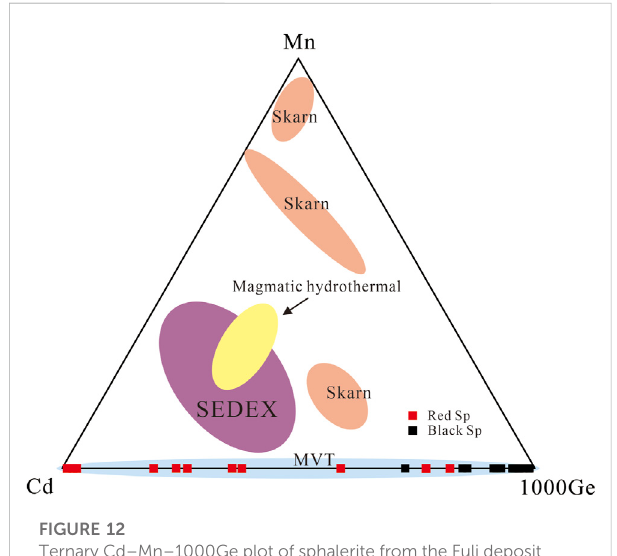
FIGURE 12 Ternary Cd – Mn – 1000Ge plot of sphalerite from the Fuli deposit modi fi ed after (Zhou et al., 2022).